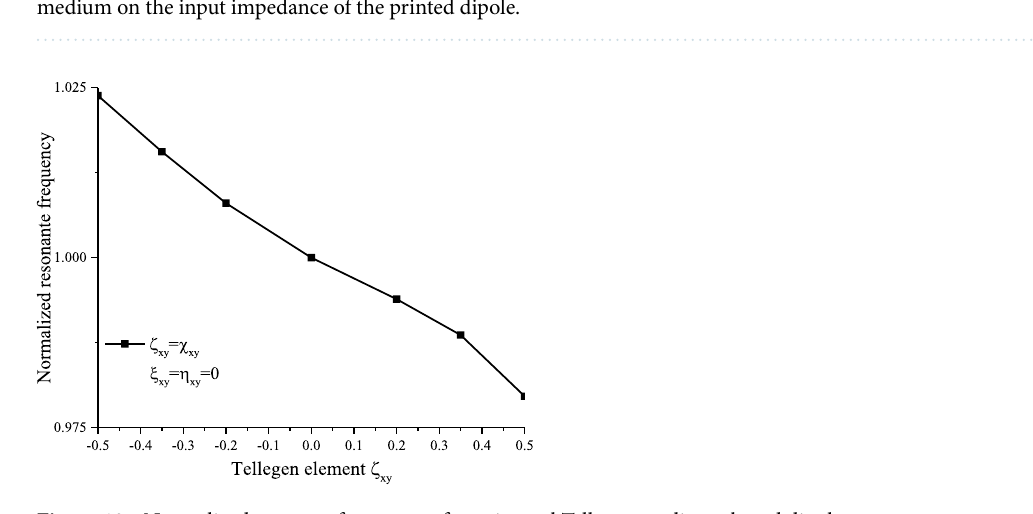
Figure 12. Normalized resonant frequency of a reciprocal Tellegen mediums-based dipole.